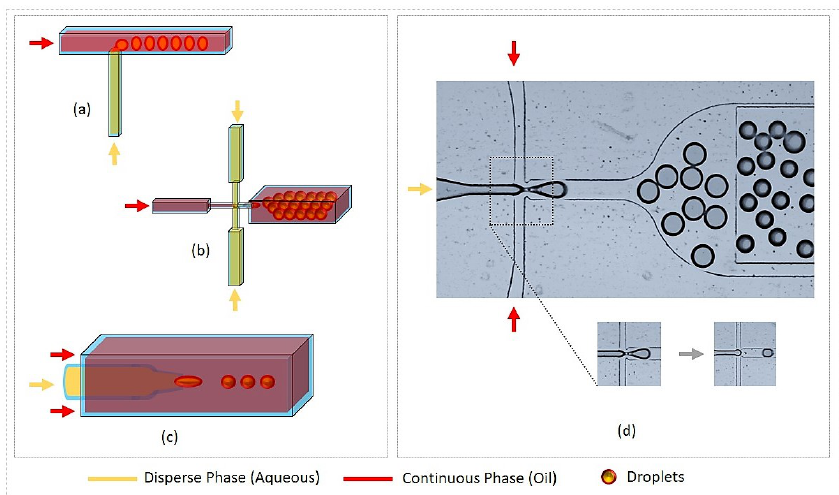
Figure 1. Droplet generation by microfluidic systems. ( a ) T-junction; ( b ) Flow-focusing; ( c ) Co-flow (glass capillary); ( d ) Droplet generation by flow focusing device (use of fluorinated oil with stabilizing agent and disperse phase as water solution of dye), device also includes on-chip storage pool for droplet collection and operation